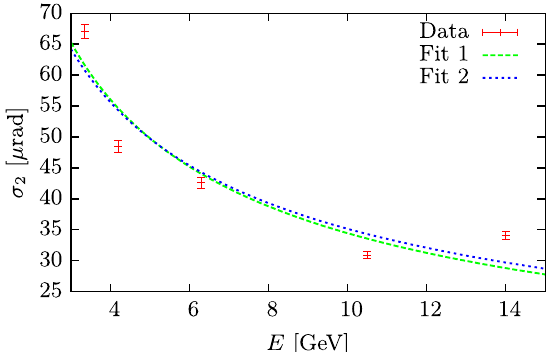
FIG. 13. A fit to the 3.5 GeV experimental data at half the crystal bending angle.